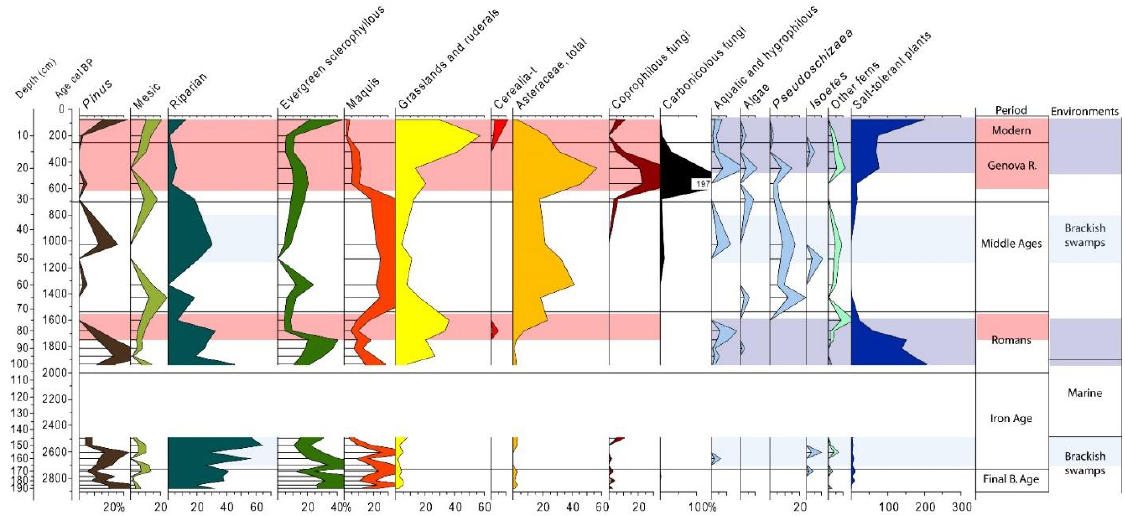
Figure 7. Synthetic pollen diagram established for the Palo pond sequence [61]. A period of cereal cultivation is dated to Late Roman times and also corresponds to an increase of ruderal plants and to a decrease in the arboreal taxa. Note the high representation of coprophilous fungi, suggesting intense pastoral activities during the Late Middle Ages and under the administration of the Genoese Republic.